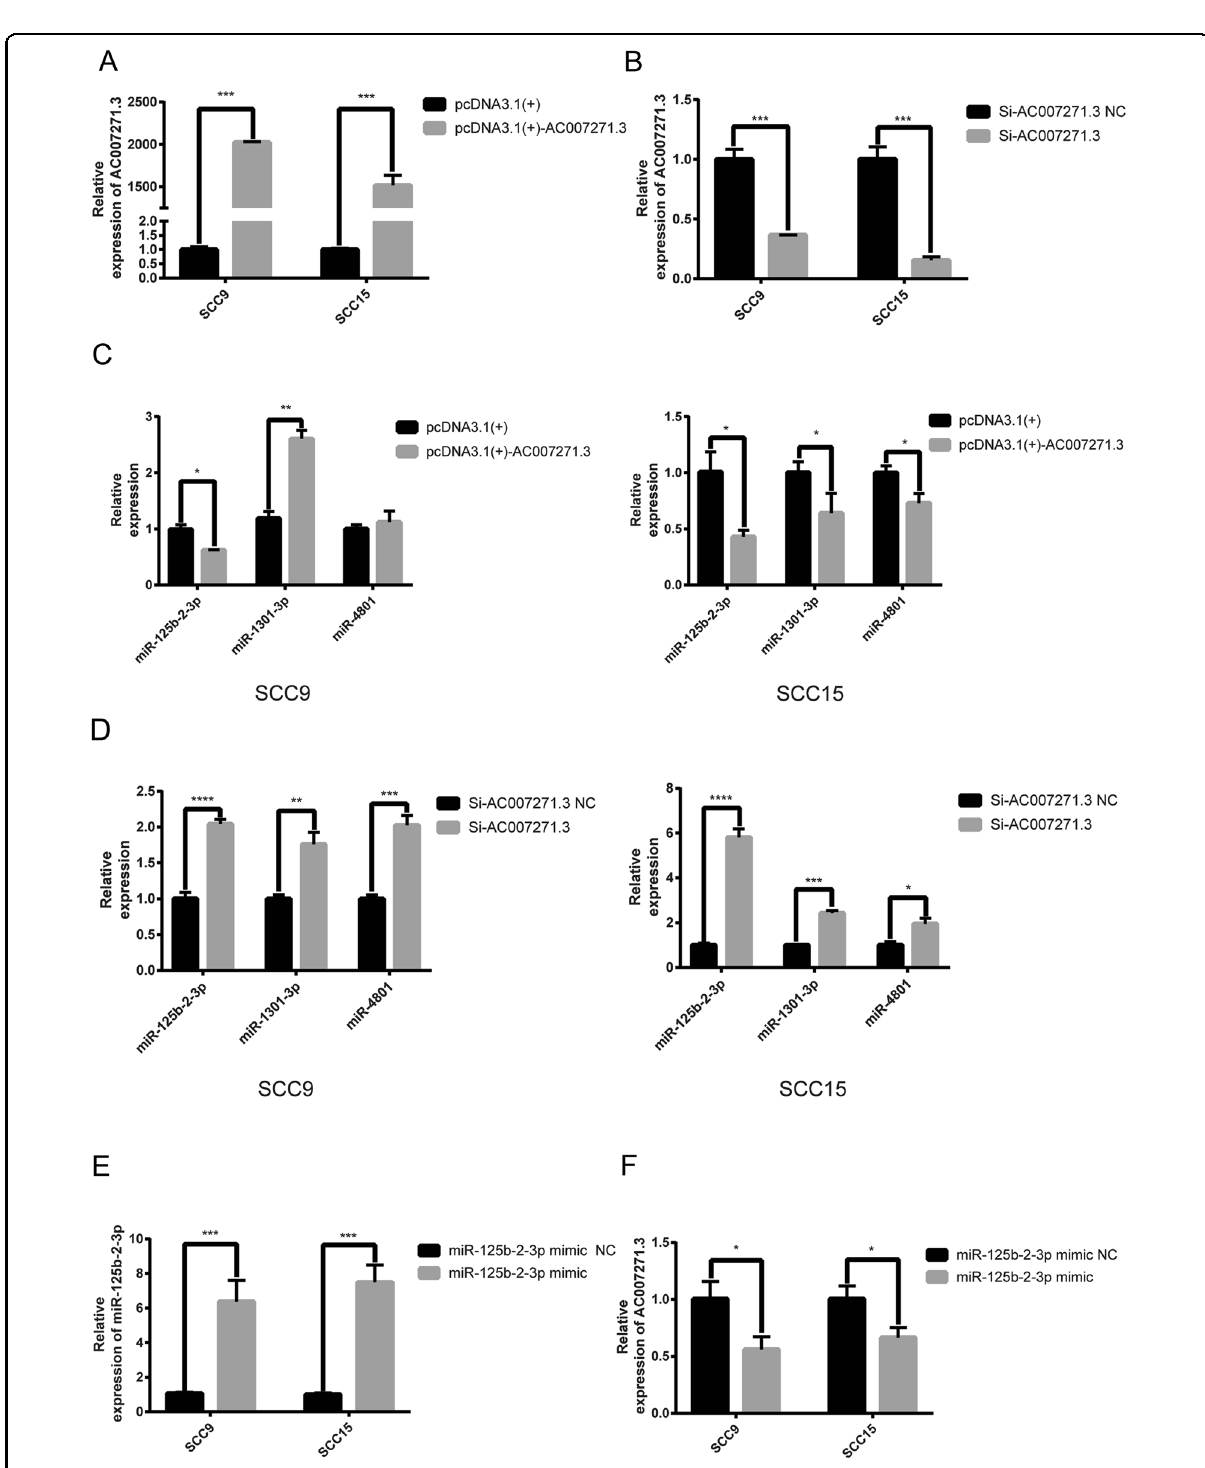
Fig. 1 AC007271.3 and miR-125b-2-3p regulated with each other. a The overexpression ef fi ciency of pcDNA3.1( + )-AC007271.3 in SCC9 and SCC15 cells. b The knockdown ef fi ciency of siRNA-AC007271.3 in SCC9 and SCC15 cells. c The expression of three predicted miRNAs after overexpressing AC007271.3. MiR-125b-2-3p were both signi fi cantly downregulated in SCC9 and SCC15. d The expression of three predicted miRNAs after knocking down AC007271.3 expression. MiR-125b-2-3p were the most signi fi cantly upregulated miRNA both in SCC9 and SCC15. e The overexpression ef fi ciency of miR-125b-2-3p mimic in SCC9 and SCC15 cells. f The upregulation of miR-125b-2-3p inhibited the expression of AC007271.3. * p < 0.05, ** p < 0.01, *** p < 0.001, **** p <